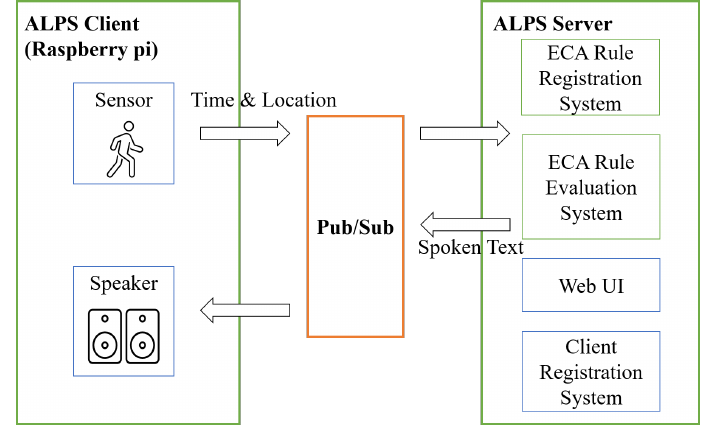
Figure 3. The previous ALPS